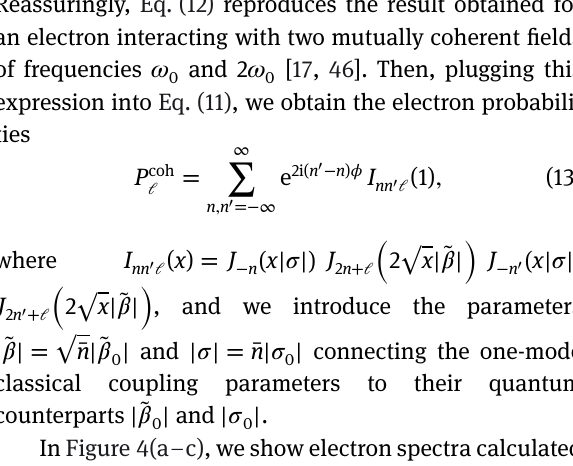
Figure 3: Postinteraction cavity-mode population. (a) Sketch of an electron wave packet undergoing a classical PINEM interaction of strength 𝛽 , and subsequently propagating in free-space for a distance d , where it develops a sequence of probability-density pulses and interacts PINEM ̃𝛽 | , determining the amount of coherence left in the two-photon and . (b) Coherence factor | M with a cavity with coupling coefficients 𝜎 0 0 m 𝜔 0 ∕ 𝑣 = 4. We plot the result as a function of the normalized coherent state [see Eq. (9a)] for the scenario depicted in panel (a) with 𝛽 PINEM for several harmonics m . (c) Position variance ⟨ Δ ̂ X 2 ⟩ for a PINEM-compressed electron [solid curves; see panel (a)] propagation distance d ∕ z T ̃𝛽 = = 0, and 𝜆 = 0. (d) Elements 𝜌 ph with 0, 𝜃 and for a perfectly coherent electron (dashed curves). We consider different real values of 𝜎 0 n nn ′ of the density matrix associated with the cavity state after interaction with a compressed electron [see panel (a)]. The interaction region is taken to be placed at the propagation distances highlighted by the color-coordinated vertical dashed lines in panel (b) assuming pairs of ̃𝛽 | = 0 . 1 and | 𝜎 | = 1 (top row); or | ̃𝛽 | = 2, | 𝜎 | = 0.1 (bottom row). All plots in panel (d) are calculated for 𝜙 = coupling parameters | 0 0 0 0